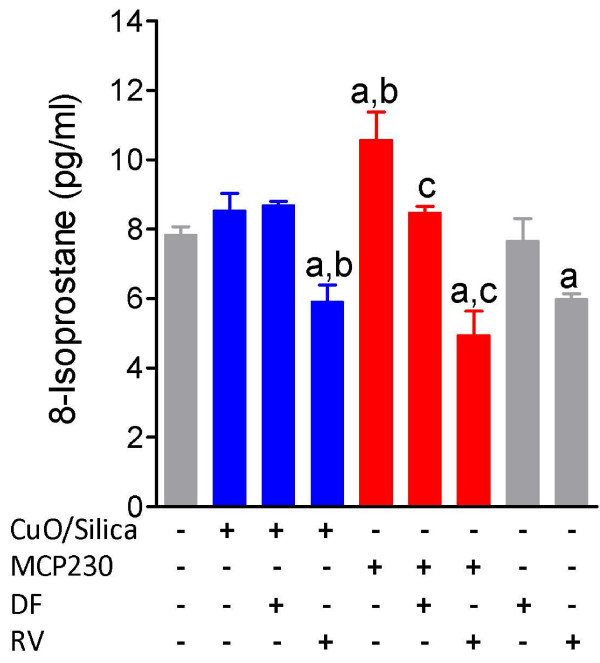
Levels of by 8-isoprostane in BEAS -2B cell supernatant. BEAS-2B cells were co-treated with 100 μM deferoxamine or 25 μM resveratrol and CuO/Silica or MCP230 ultrafine particles for 4 h in a 6-well plate with 1 ml culture media. Results are expressed as mean ± SEM. Significantly different from auntreated controls; bCuO/Silica; cMCP230.